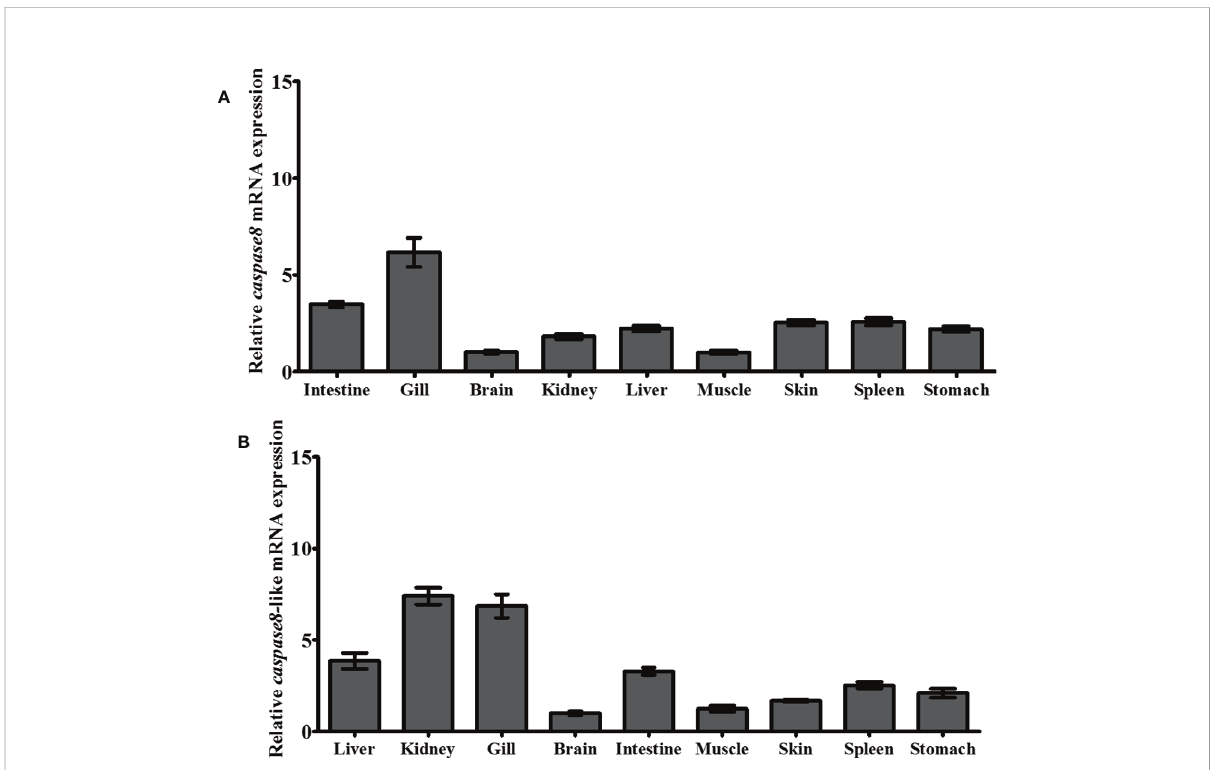
FIGURE 4 Relative expression levels of cas8 [ (A) , Tocas8; (B) , Tocas8-like] mRNA in different tissues of golden pompano. These tissues included the liver, kidney, gill, brain, intestine, muscle, skin, spleen, and stomach. b -actin was selected as an internal reference gene to calibration cDNA template. These values are presented as mean ± standard deviation (n =